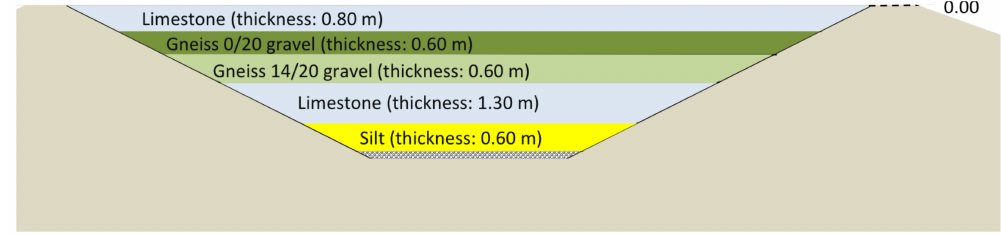
Figure 8. Transversal section of the multilayer region, showing the stratification of materials and the thicknesses of the